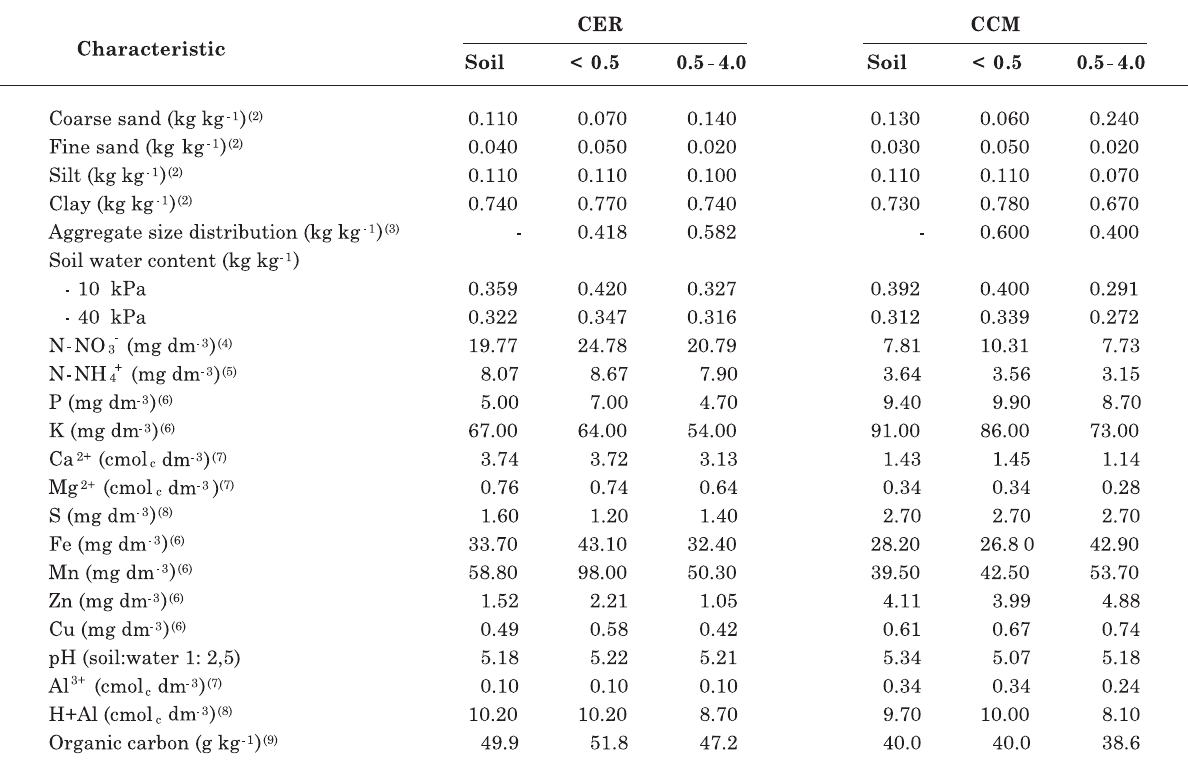
Table 1. Physical and chemical characterization of soil and aggregates (< 0.5 and 0.5–4.0 mm) in samples of an Red Oxisol under two management systems